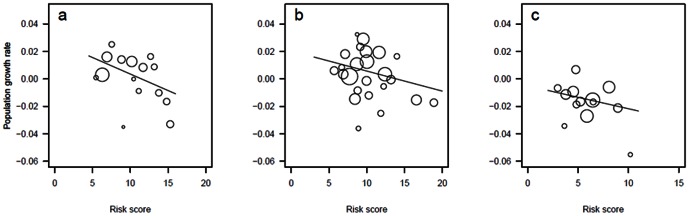
The relationship between risk score (with no scaling mechanism) and annual population growth rate of 52 forest bird species.Species with different migration strategies are presented separately: a) non-migratory (y = −0.002x+0.03, r2 = 0.29); b) within Europe migrants (y = −0.001x+0.02, r2 = 0.09); c) wintering outside Europe (y = −0.002x+−0.005, r2 = 0.07). The sizes of data points are proportional to the standard error of population growth rate estimate, with larger points having smaller standard error and thus greater weight in models. Relationships were tested concurrently with migration strategy as a separate term in the model (P = 0.01, see text for details).